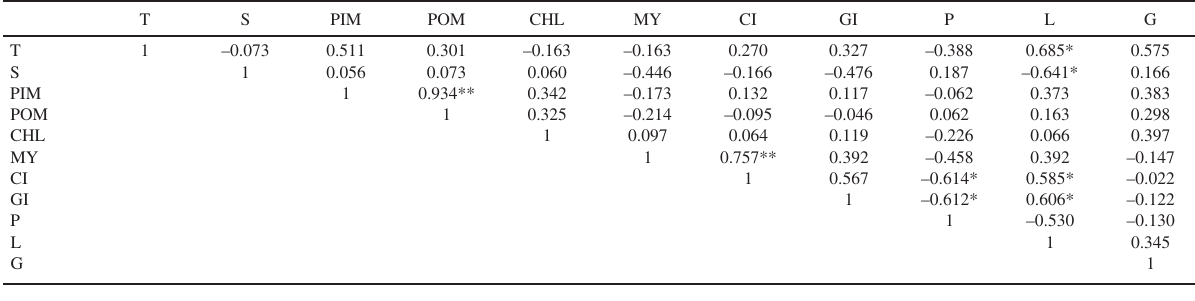
Table 2. – Matrix of Pearson correlation of temperature (T), salinity (S), particulate inorganic matter (PIM), particulate organic matter (POM), chlorophyll a (CHL), meat yield (MY), condition index (CI), gonad index (GI), protein (P), total lipids (L) and glycogen (G). * Correlation is significant at the 0.05 level (two-tailed); ** Correlation is significant at the 0.01 level (two-tailed).